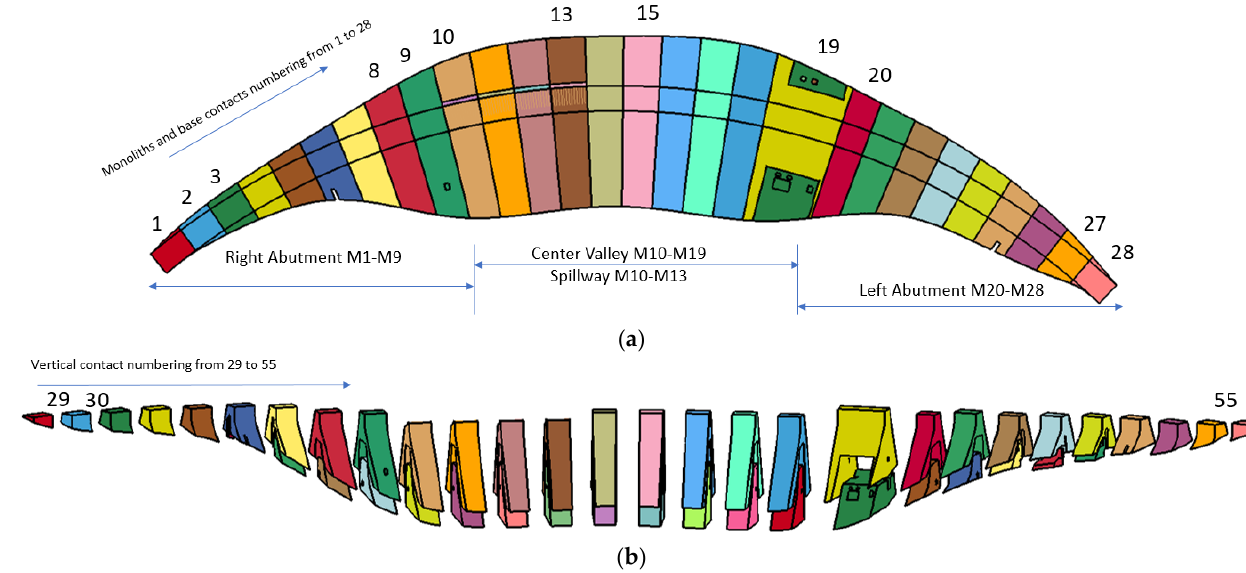
Figure 3. Scoggins RCC Dam LSDYNA Model: ( a ) plan view; ( b ) exploded isometric view. Plan and outer profile view colors represent different monoliths in the dam. Inner color shown on profile represents the inner zone of RCC materials with different material properties.